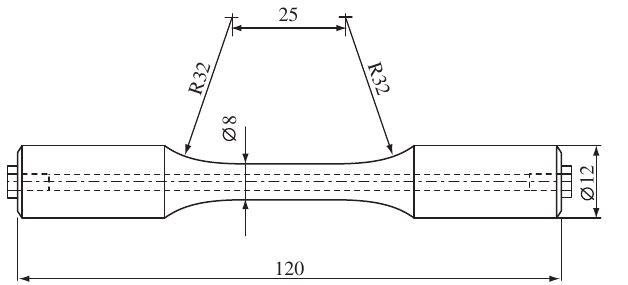
Carbon Activity in the Gas